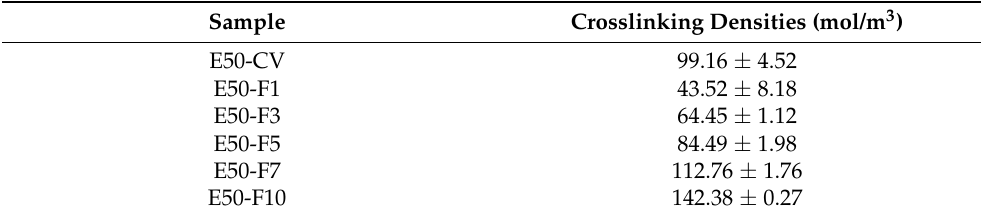
Table 5. Crosslinking densities of ENR-50 compounded with various concentrations of FeCl 3 and the conventional sulfur vulcanization (i.e., E50-CV).